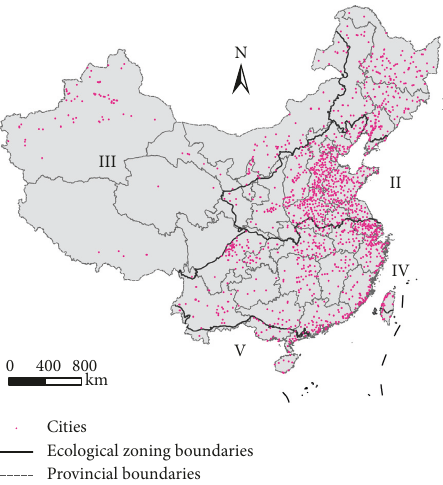
Figure 1: Locations of the 1449 cities selected for this study in the five environmental